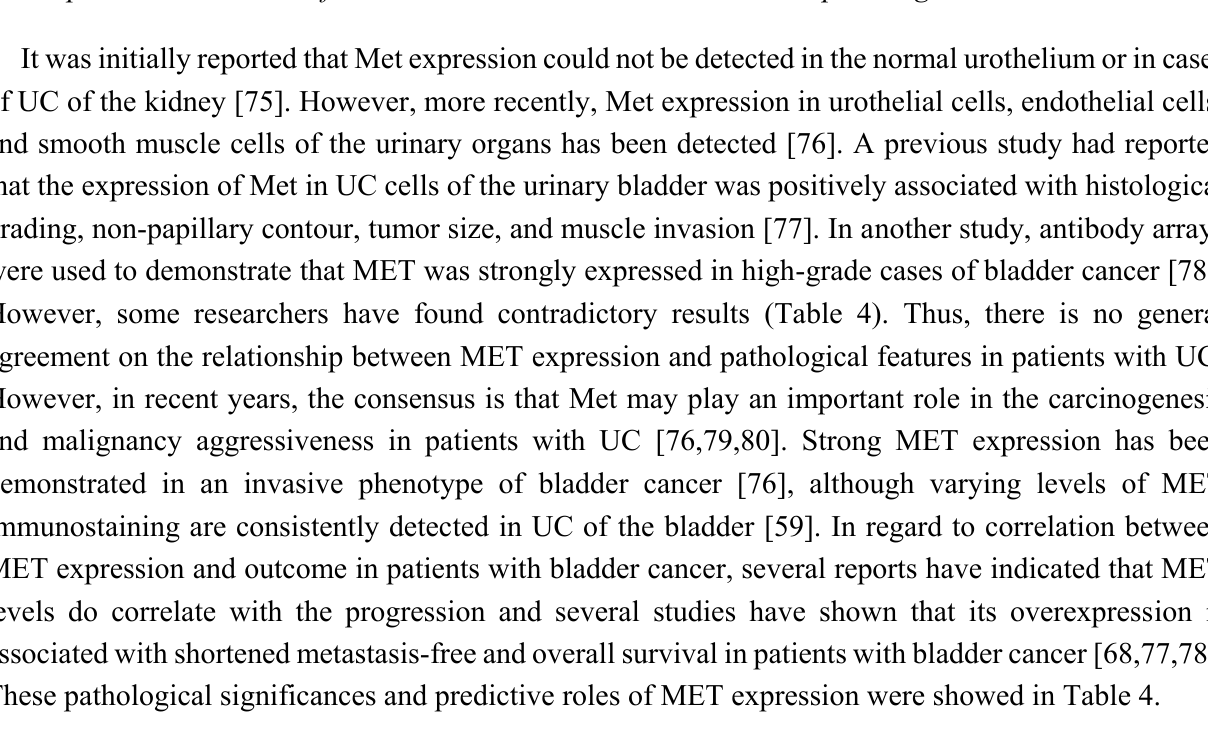
Table 4. Relationship between MET expression and pathological features and survival in urothelial